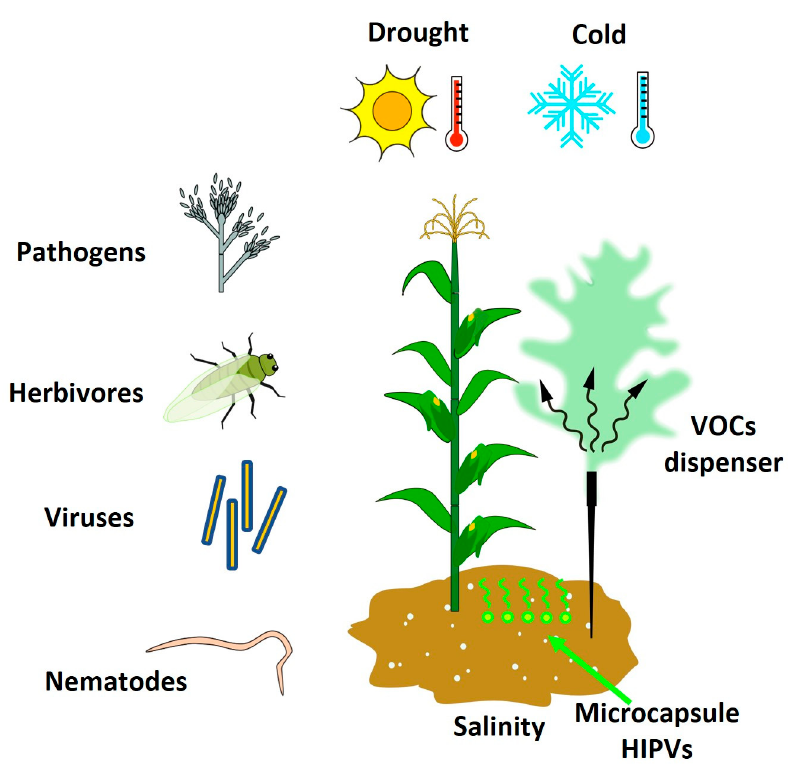
Figure 5. The HIPVs as inductors of resistance against biotic and abiotic stresses. Table 3. Volatile organic compounds with application in biocontrol against biotic and abiotic stress.